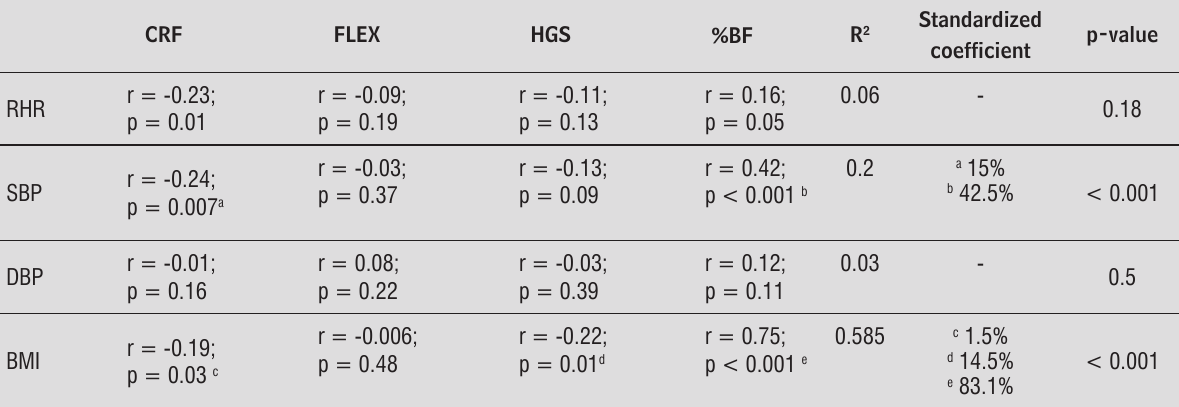
Table 3 - Relationship between indicator variables of physical fitness and health in the men